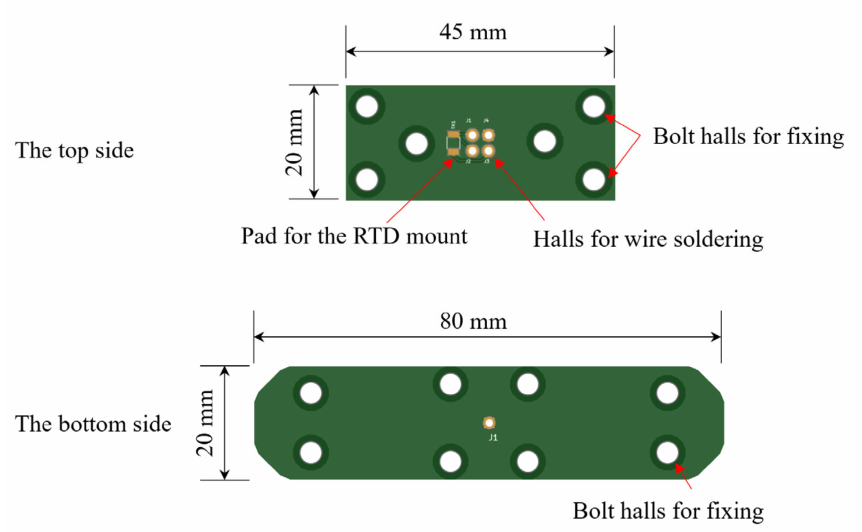
Figure 10. Drawing of the two plate electrodes using a PCB pattern.